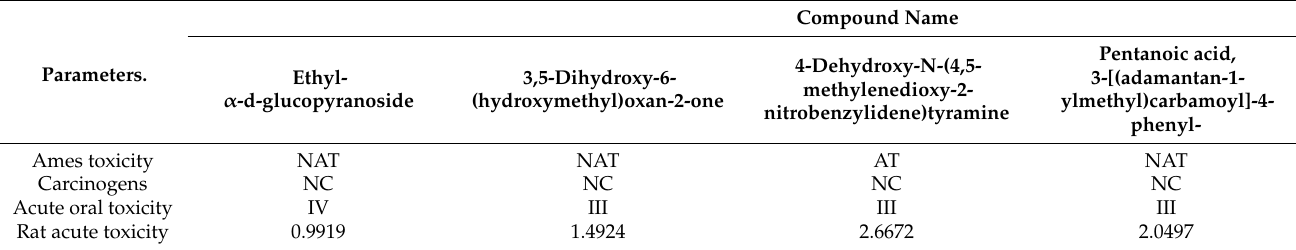
Table 9. Toxicological properties of the highest affinity ligands on NOD-like receptor signaling pathway.